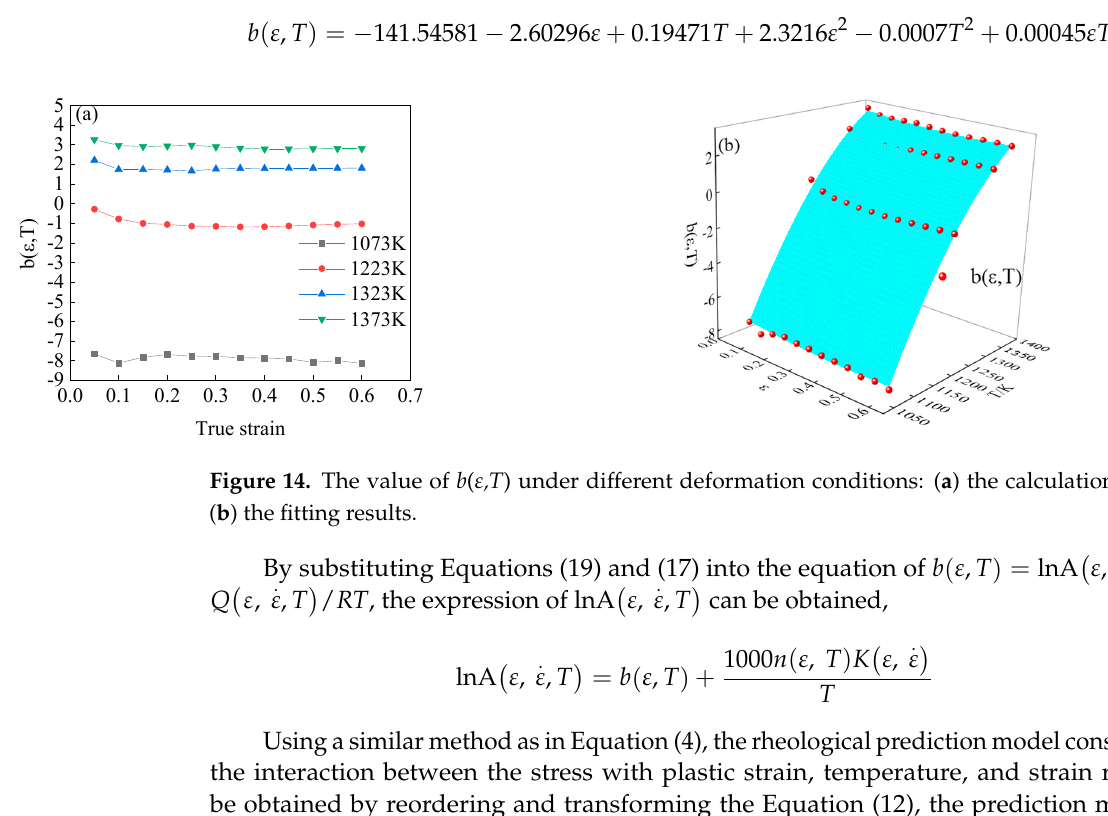
strain. The function of 𝑏(𝜀, 𝑇) can be obtained through 3D surface fitting, as shown in